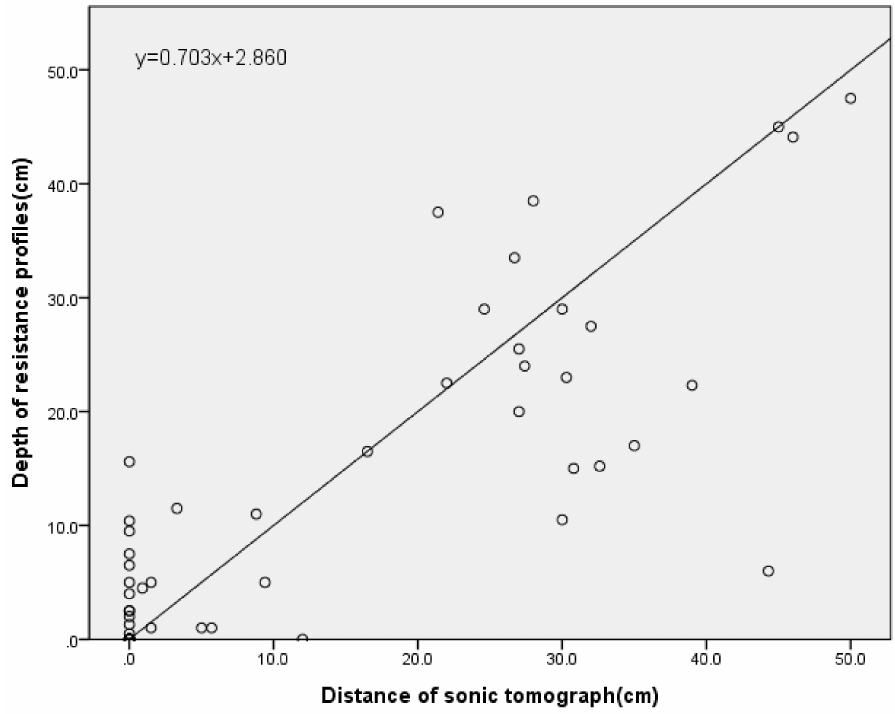
Figure 2. Predicted distance of compromised wood using sonic tomography versus the distance of defects using resistography. Trend line = linear regression. p < 0.001, r 2 = 0.675, n =